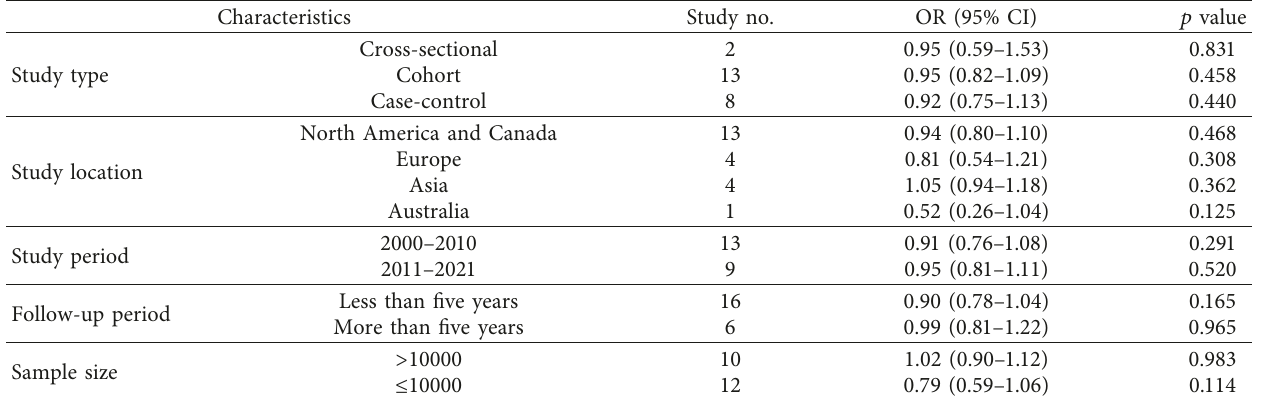
Table 4: Subgroup analysis of the relationship between statin consumption and risk of developing age-related macular degeneration. Characteristics Study no. OR (95% CI) p